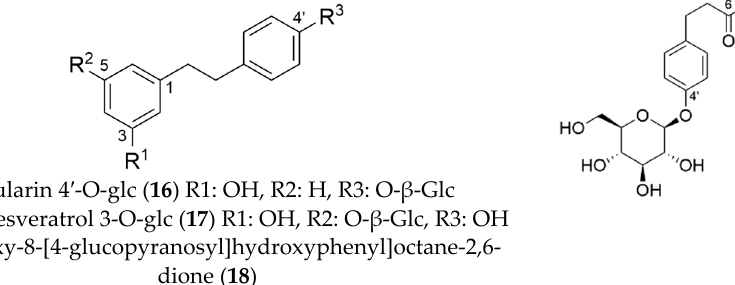
Figure 6. Molecular structures of dihydrostilbenoids and a related substance isolated from Hydrangea macrophylla ssp. serrata.